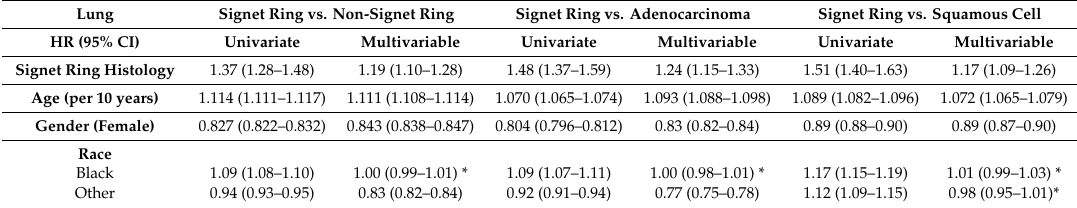
Table 10. Derived univariate and multivariable Cox-proportional hazard ratios (HR) of mortality for lung